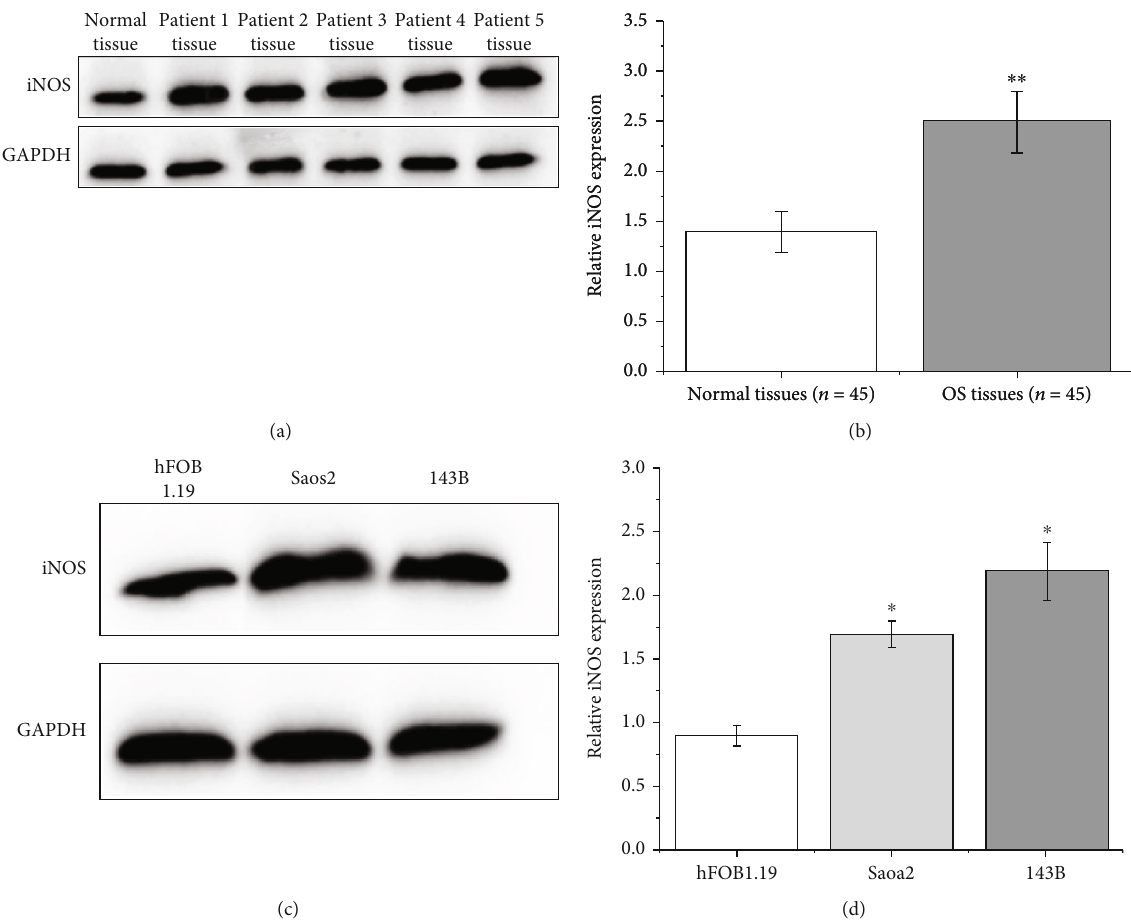
Figure 1: iNOS is upregulated in osteosarcoma (OS) tissues and cells. (a) The representative image of the iNOS expressions in normal tissue and 5 patients ’ tissues by western blotting. (b) The iNOS expressions in 45 normal tissues and 45 OS tissues ( ∗∗ p < 0 : 01 ). (c, d) The iNOS expressions in hFOB1.19, Saos2, and 143B cells ( ∗ p < 0 : 05